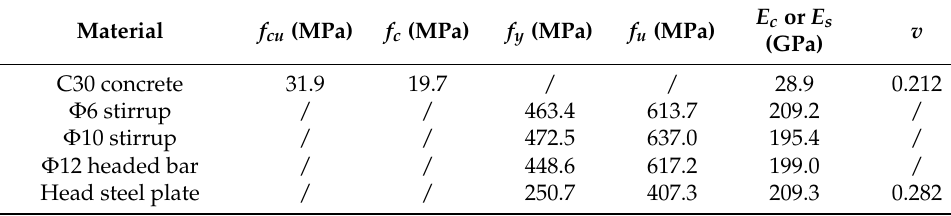
Table 2. Mechanical properties of concrete and steel.